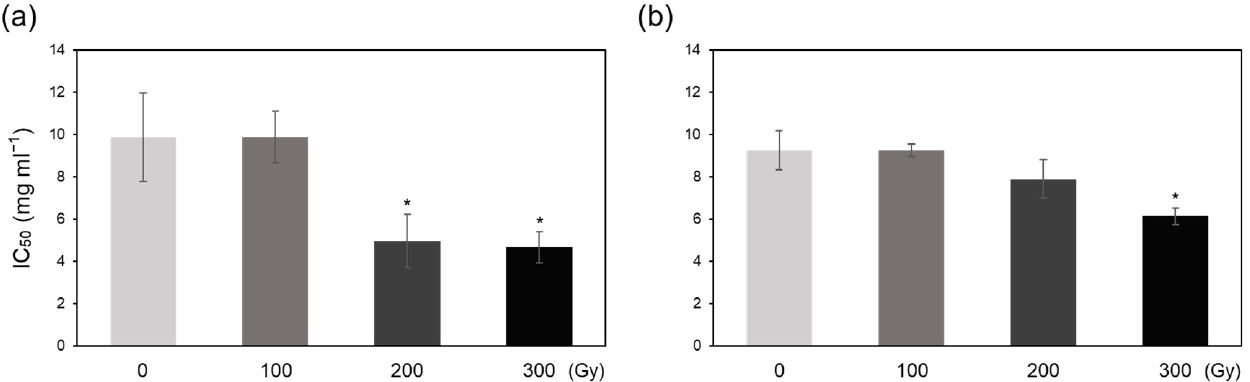
Figure 3. Quantification of hydrogen peroxide (H 2 O 2 ) and malondialdehyde (MDA) contents of rice plants subjected to acute and chronic gamma irradiation. ( a , b ) H 2 O 2 contents of plants subjected to acute ( a ) and chronic ( b ) gamma irradiation. ( c , d ) MDA contents of plants subjected to acute ( c ) and chronic ( d ) gamma irradiation. Data represent mean ± SD. Asterisks indicate significant differences between control (0 Gy) and other treatments (* p < 0.05, ** p < 0.01, *** p < 0.001).